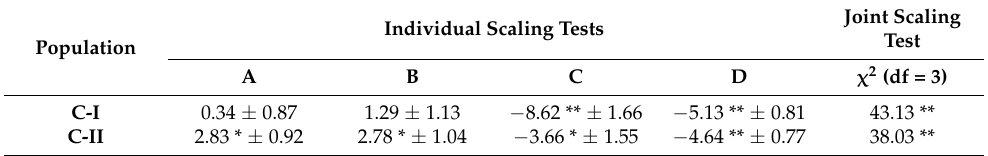
Table 5. Estimates of individual and joint scaling tests in two populations of Indian mustard.